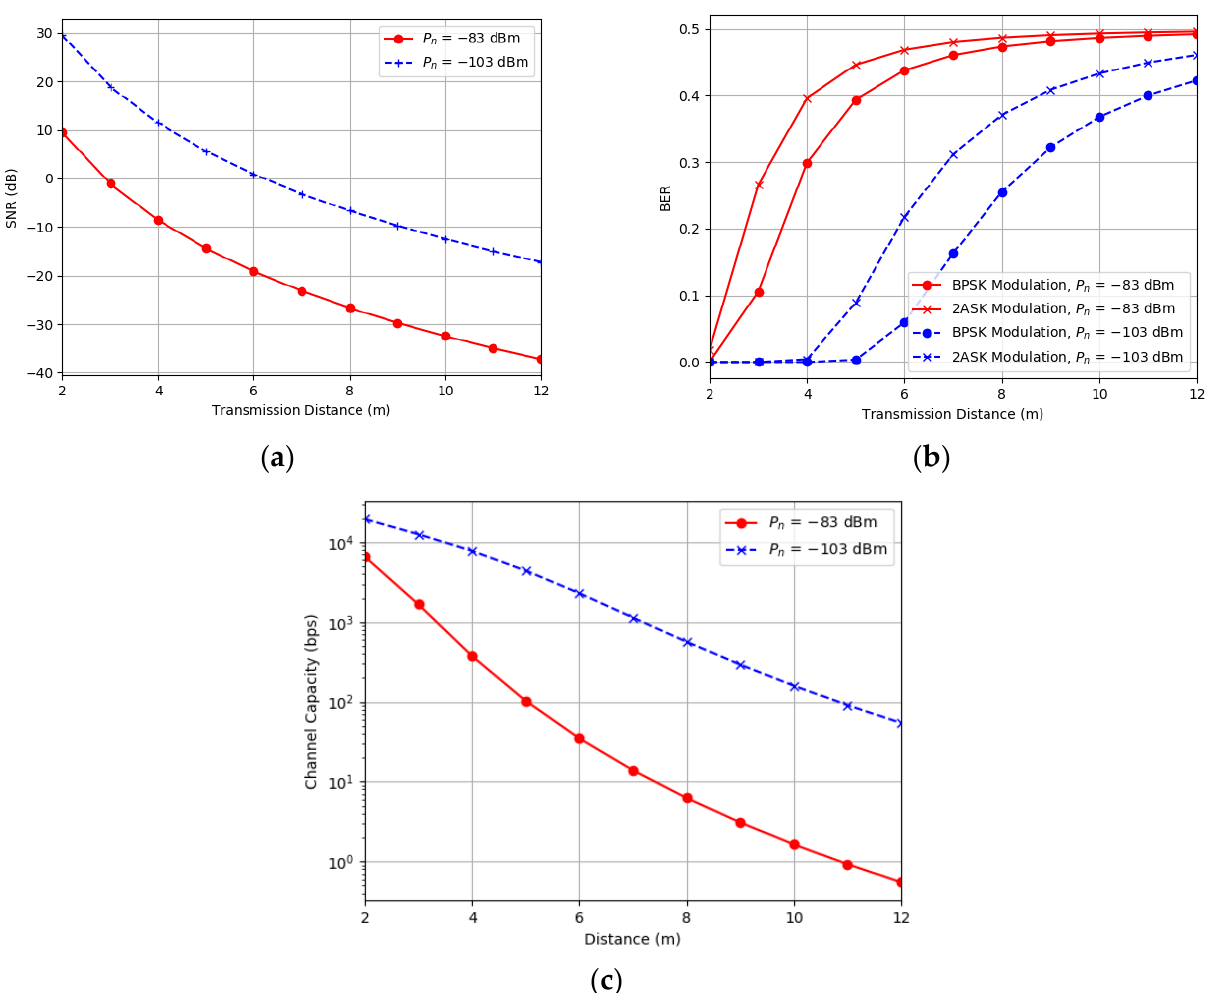
Figure 5. Single-hop underground MI communication performance. The panels show the variation in the ( a ) signal-to-noise ratio (SNR (dB)), ( b ) channel capacity (bps) and ( c ) bit error rate (BER) over the transmission distance at low noise power ( P n = − 103 dBm) and high noise power ( P n = − 83 dBm ) for the binary phase shift keying and binary amplitude shift keying modulation schemes.